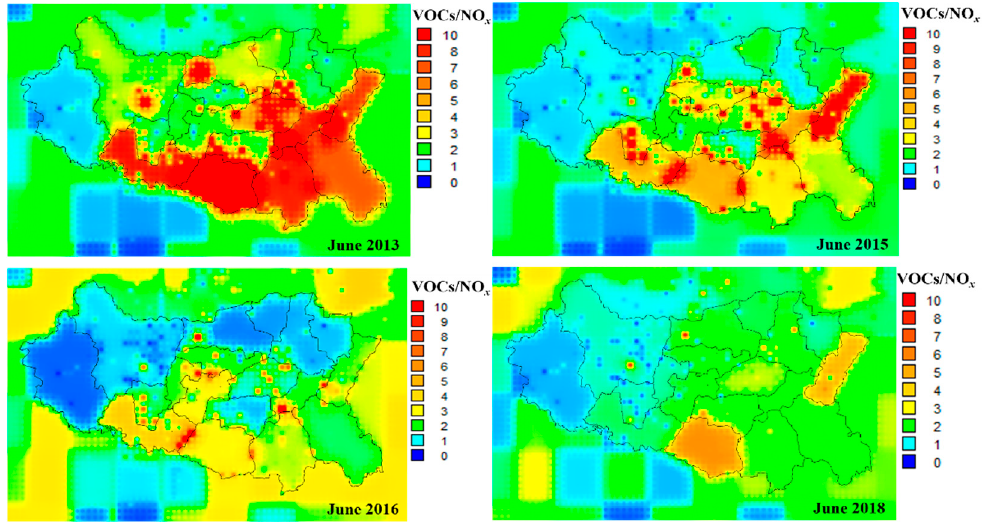
Figure 6. Spatial distribution of the ratio of VOCs emissions (anthropogenic VOCs and biogenic VOCs) to NO x emissions (VOCs/NO x ) over Handan and its surrounding areas in June 2013, June 2015, June 2016 and June 2018.